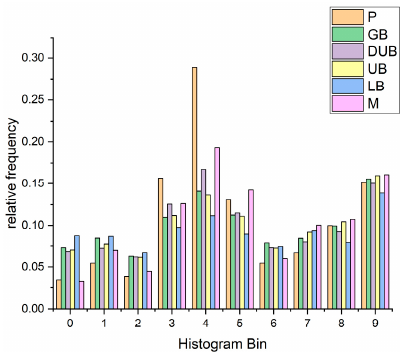
Figure 9. LBP 1/8 for representative images from Figure 5 for all six microstructure classes, showing differences in the separate bins of the histogram.